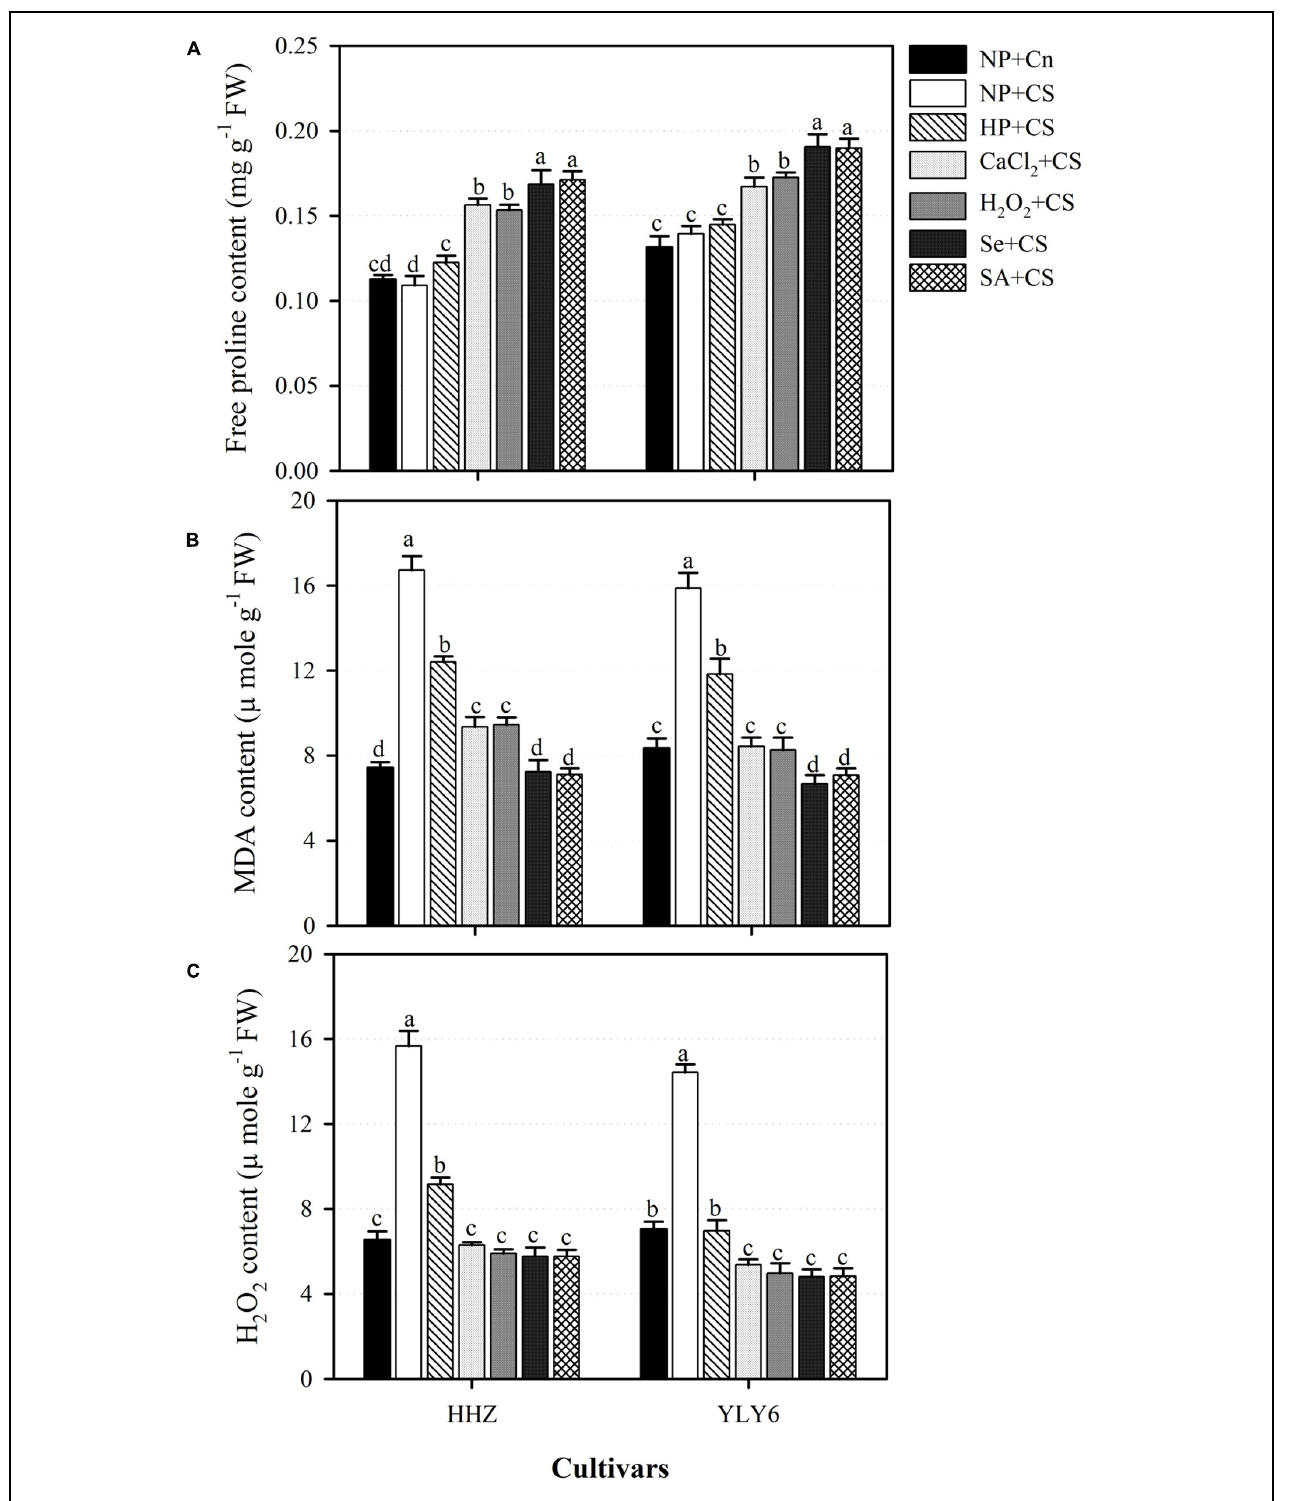
FIGURE 5 | Influence of various seed priming treatments on (A) free proline, (B) MDA content, and (C) H 2 O 2 content of rice seedlings under chilling stress. Vertical bars above mean indicate standard error of six replicates. Mean value for each treatment with different lowercase letters indicate significant differences by the LSD-test ( P < 0.05). NP + Cn: no priming and no stress, NP + CS: no priming and chilling stress, HP + CS: hydropriming and chilling stress, CaCl 2 + CS: calcium chloride priming and chilling stress, H 2 O 2 + CS: hydrogen peroxide priming and chilling stress. Se + CS: selenium priming and chilling stress, and SA + CS: salicylic acid priming and chilling stress, Cn: 28 ◦ C, CS: 18 ◦ C, HHZ: inbred cultivar huanghuazhan, YLY6: hybrid variety Yangliangyou-6.